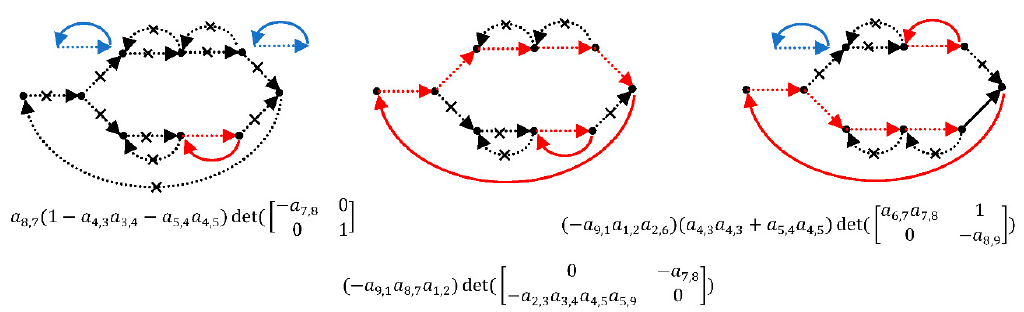
Figure 5. Graph decomposition of example 2.